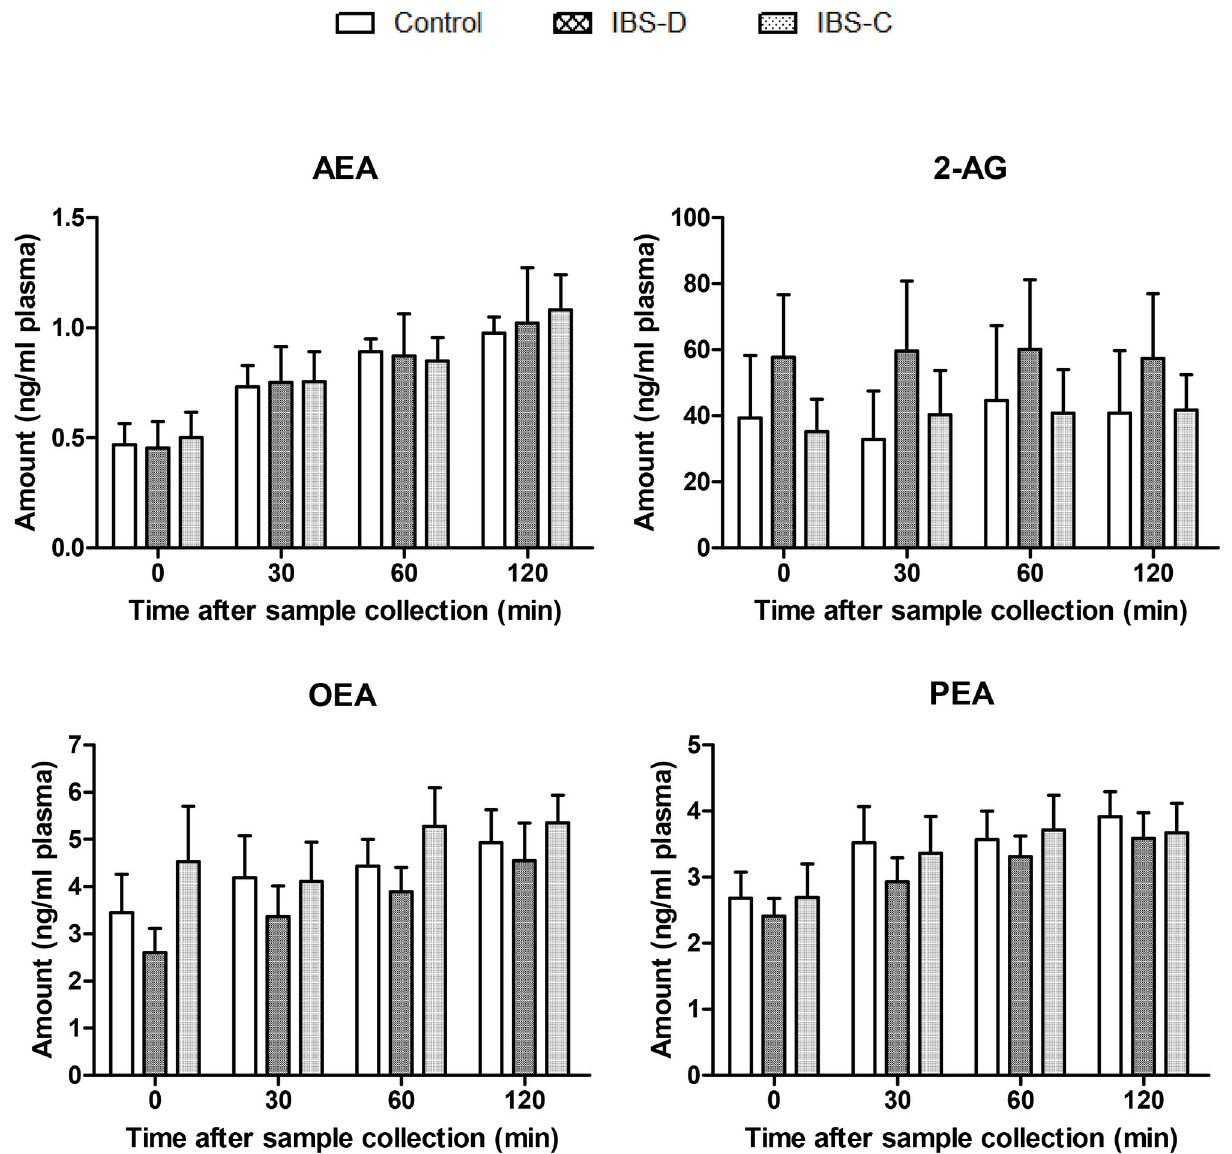
Figure 1. Endocannabinoid (anandamide, AEA; 2-arachidonoyl glycerol, 2-AG) and cannabinoid-like fatty acid amide ( N - oleoyl ethanolamine, OEA; N- palmitoyl ethanolamine, PEA) levels in plasma 0, 30, 60 and 120 min after blood sample collection from IBS-D and IBS-C patients vs. healthy controls . The results are shown as mean ± SEM of n=7 for each group. Each sample was run in triplicate.